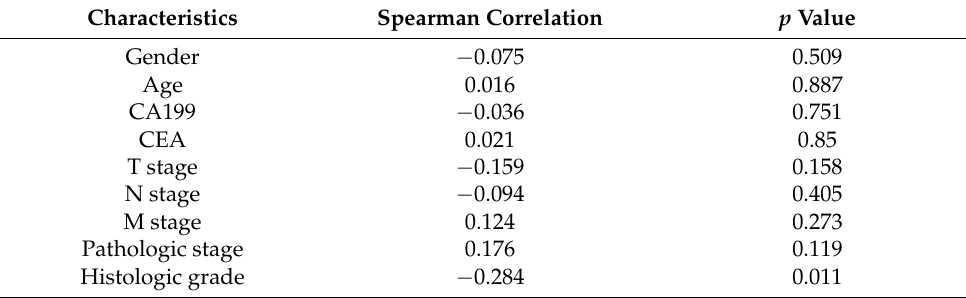
Table 2. Spearman analysis between EVL and clinical characteristics.